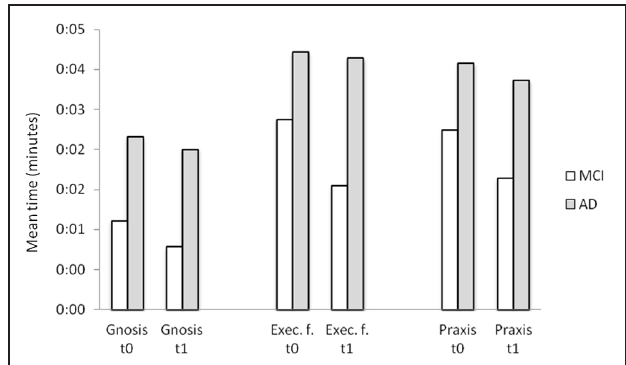
FIGURE 2 | Mean time spent on the different game activities the first time a scenario was played (t0) and one week after (t1) for MCI and AD